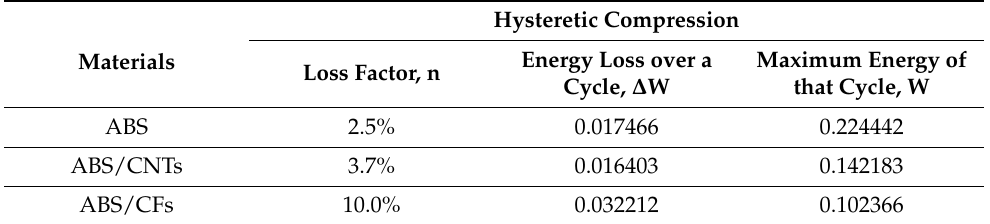
Table 2. Hysteretic damping properties of the ABS, ABS/CNT and ABS/CF FFF printed